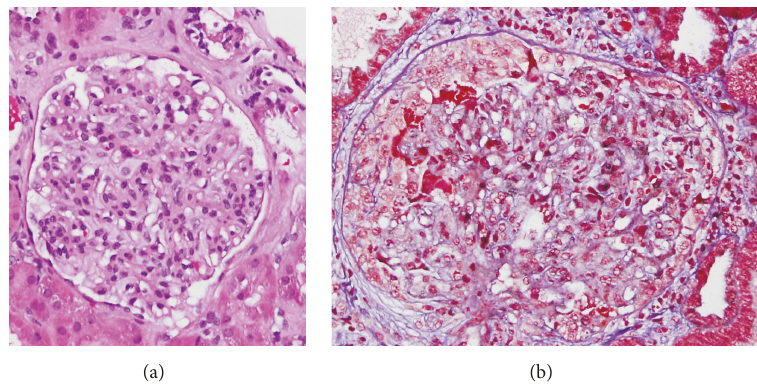
Figure 1: Light microscopy H&E (a) and PAS (b) showing mesangial